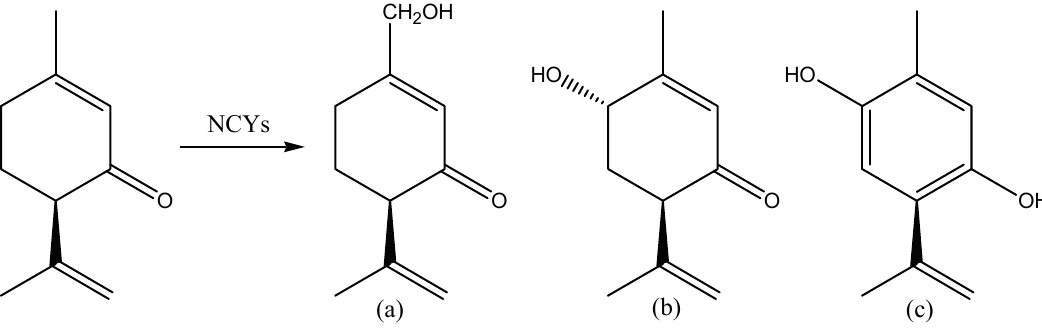
Figure 4. NCYs catalyzed biotransformation of ( − )-piperitone to (4 R )-7-hydroxy-piperitone ( a ); (4 R ,6 S )- trans -6-hydroxy-piperitone ( b ) and 2-isopropyl-5-methyl-hydroquinone ( c